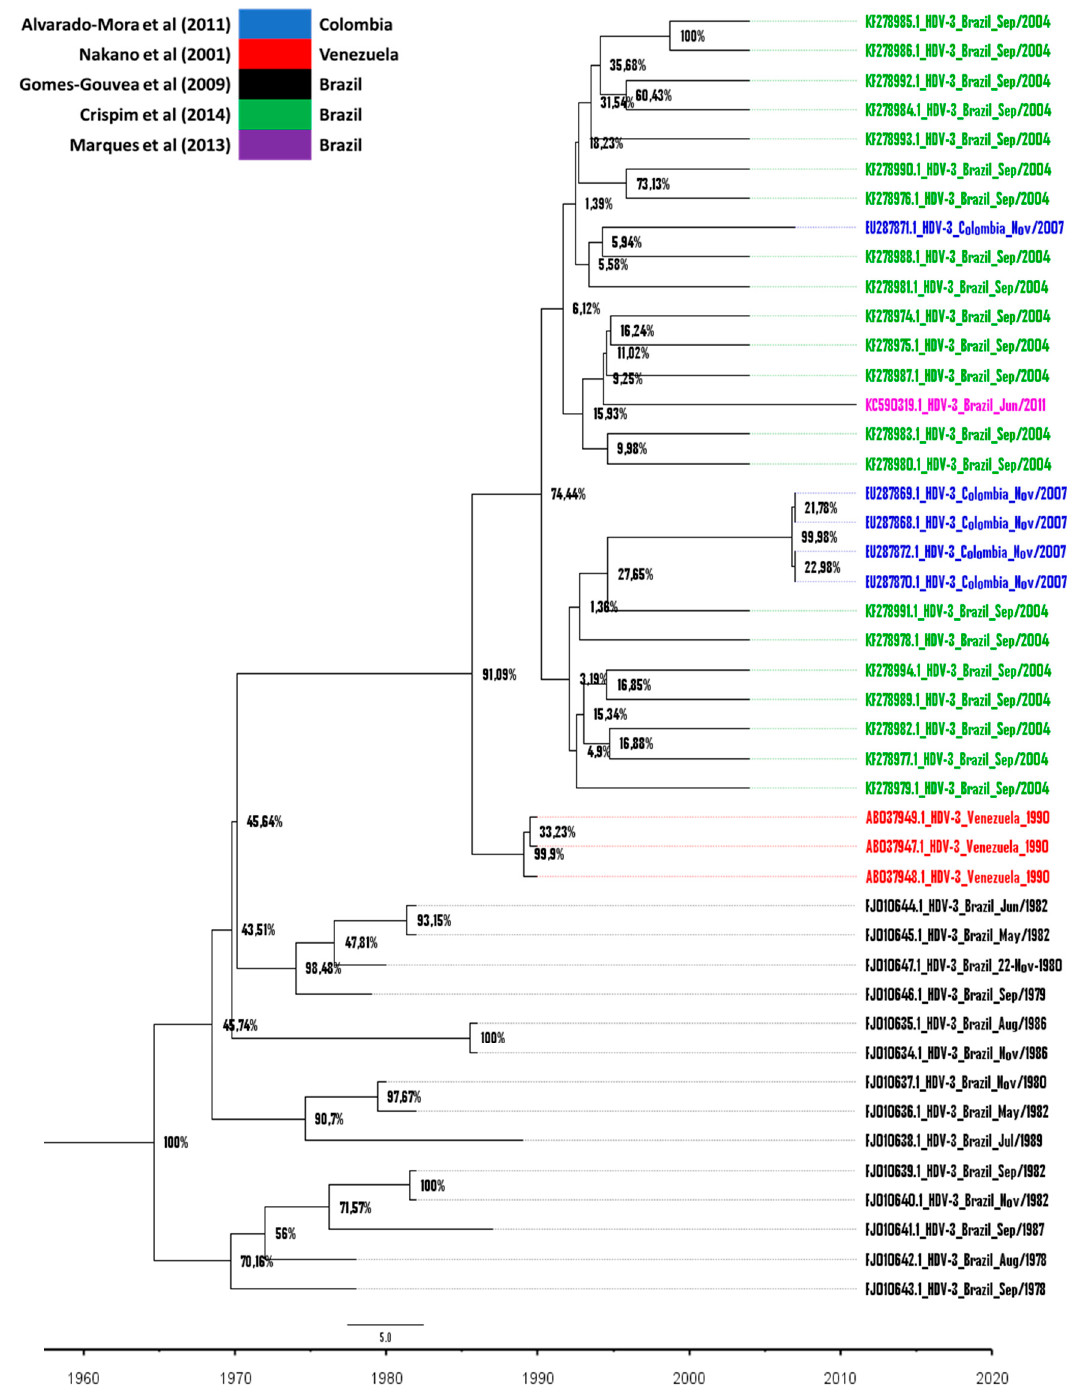
Figure 3. Bayesian phylogenetic tree. In the maximum clade credibility (MCC) tree generated, the phylogenetic relationship was estimated by Bayesian analysis among 44 strains of HDV-3 isolated in South America from 1978 to 2011. Red color taxa correspond to sequences from [28]; blue corresponds to those from [24]; green to those from [27]; black to those from [22] and purple to that from [29] (Table 1). In each node the posterior probability rate is shown as percentage data and in the lower part, the time in years is displayed. The time to the Most Recent Common Ancestor (tMRCA) dating back to 1964 is demonstrated for this tree